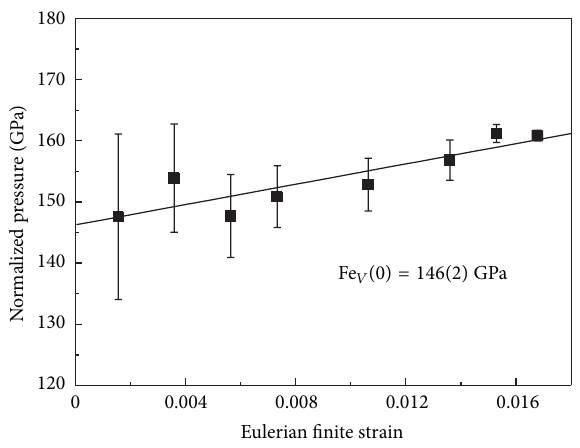
Figure 4: Eulerian strain-normalized pressure ( 𝑓 𝐸 - 𝐹 𝐸 ) plot of the data based on the Birch-Murnaghan equation of state. The solid line represents the linear fit.